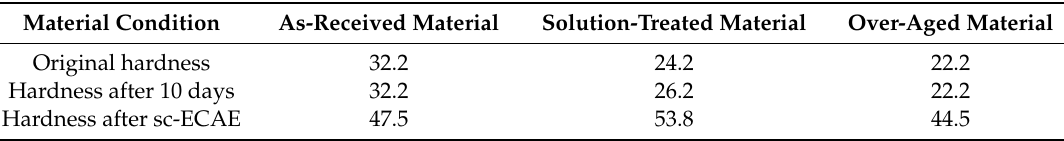
Table 1. Hardness (HRB) of aluminum alloy AA5083. Sc-ECAE—semi-continuous equal-channel angular extrusion.